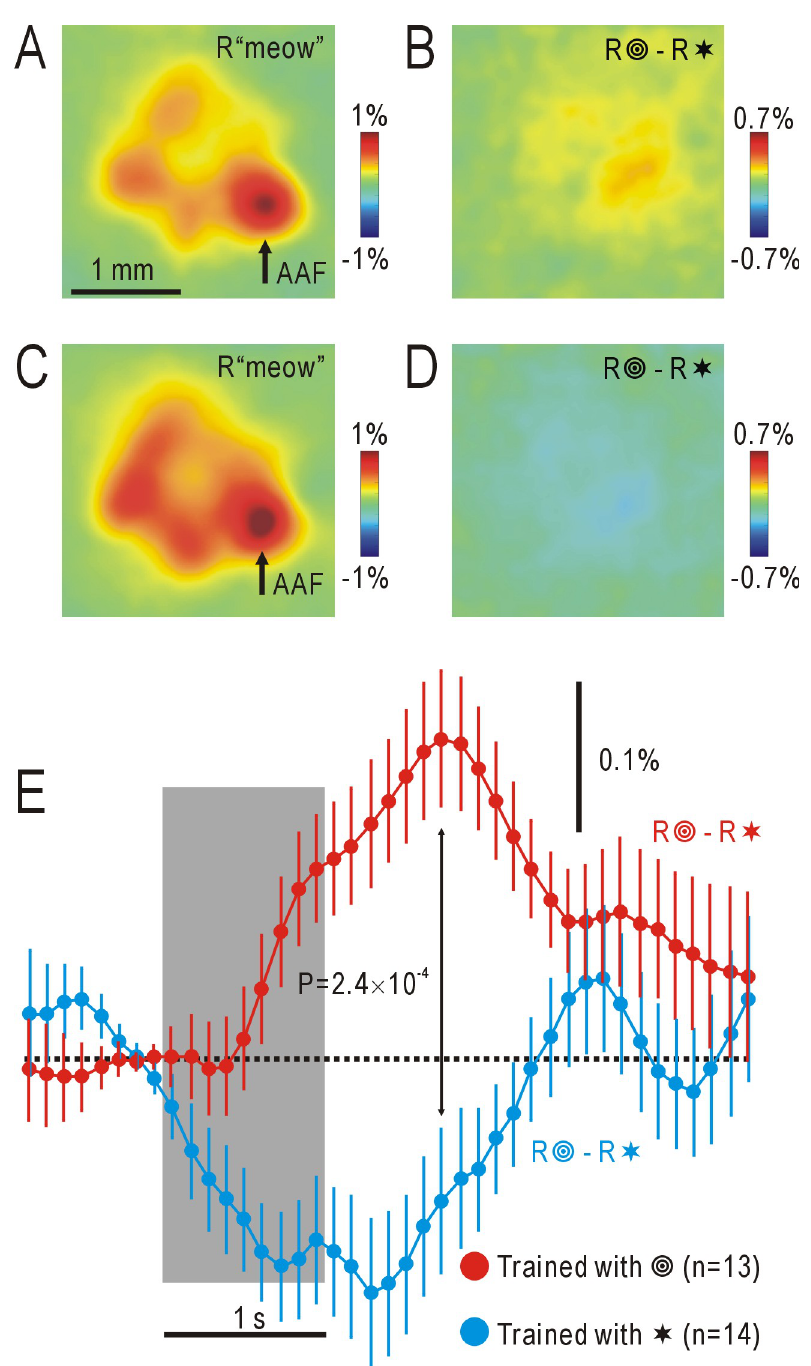
Fig 3. Averaged responses to auditory or visual shape stimuli in the AC. (A) Averaged responses in the AC to the “meow” stimulus in 13 mice pre-exposed to a combination of the “meow” sound and concentric circles (R“meow”). Arrow shows the position of AAF. The pseudocolor scale shows Δ F/F 0 . (B) Associative auditory responses calculated as the differential responses to concentric circles (test) and stars (control) in the same 13 mice shown in (A) (R —R ✶ ). Note the responses with positive amplitudes. (C) Averaged responses in the AC to the “meow” stimulus in 14 mice pre- exposed to a combination of the “meow” sound and stars (R“meow”). (D) Associative auditory responses calculated as the differential responses to concentric circles (control) and stars (test) in the same 14 mice shown in (C) (R —R ✶ ). Note the responses with negative amplitudes. Data shown in (A) and (C) were recorded 1 s after stimulus onset, and those in (B) and (D) were recorded 1.8 s after stimulus onset. (E) Time courses of Δ F/F 0 within the circular ROI centered on AAF in (B) and (D). Dots with lines show means and SEMs. https://doi.org/10.1371/journal.pone.0223242.g003 PLOS ONE | https://doi.org/10.1371/journal.pone.0223242 October 3,